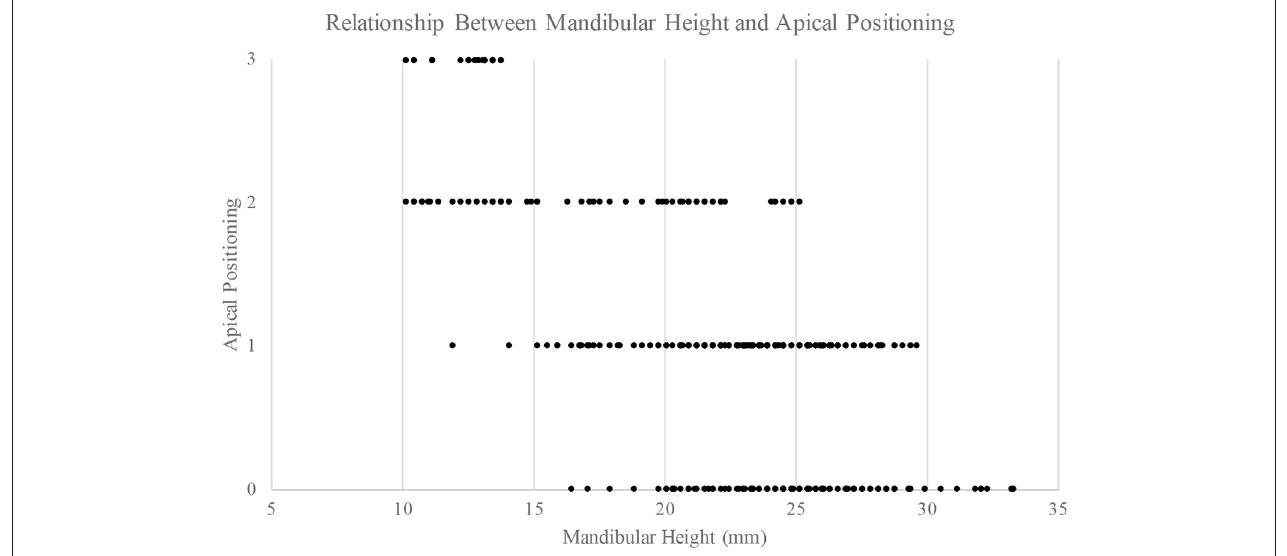
FIGURE 4 | Relationship between mandibular bone height (mm) and apical position of tooth